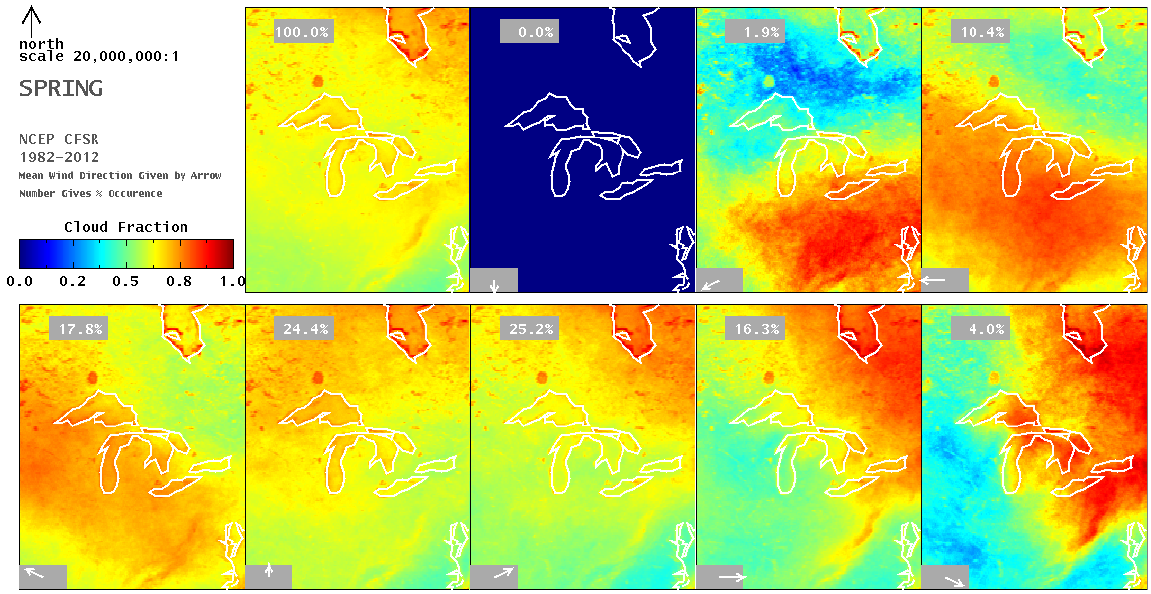
Figure 10. PATMOS-x cloud cover for the region during the 31-year time period during the spring months (March, April and May) composited with respect to wind direction. Same as Figure 7 except for